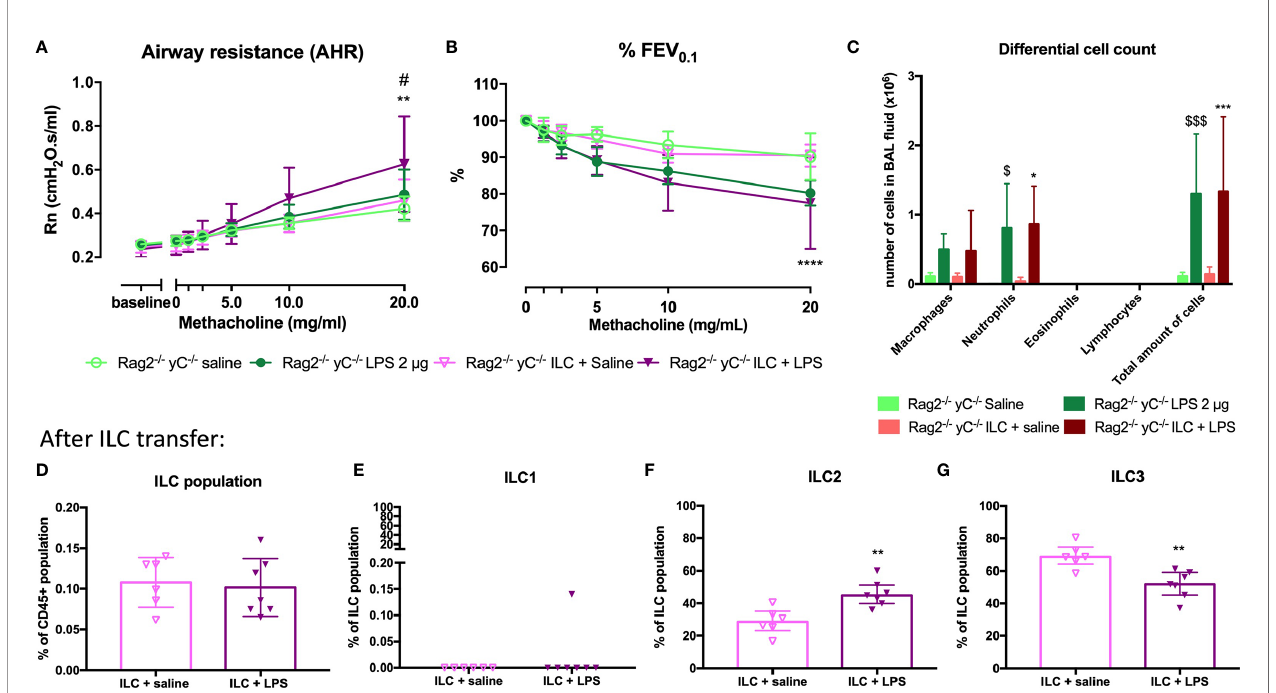
FIGURE 7 | Effect of adoptive transfer of ILC in Rag2 -/- g C -/- mice. ILC cells were isolated by sorting from lung tissue of SCID mice and intravenously injected (10 4 cells) in Rag2 -/- g C -/- mice. Twenty-four hours after the adoptive transfer, Rag2 -/- g C -/- mice were endonasally exposed to LPS (2 µg in 50 µl saline) on four consecutive days. Twenty-four hours after the last LPS challenge, lung function parameters were measured using the FlexiVent, and BAL fl uid was obtained for differential cell count and lung tissue for ILC identi fi cation. Airway resistance [Rn, (A) ] and FEV 0.1 [%, (B) ] before and after methacholine provocation (0 – 20 mg/ml) were measured in saline-treated Rag2 -/- g C -/- mice (n = 5), LPS-treated Rag2 -/- g C -/- mice (n = 6), saline-treated Rag2 -/- g C -/- mice after ILC transfer (n = 6), and LPS-treated Rag2 -/- g C -/- mice after ILC transfer (n = 6). Data are represented as mean with standard deviation. Two-way ANOVA was used to determine signi fi cant differences. Differential cell count in BAL fl uid of the same mice is shown in (C) . Total ILC population (D) , ILC1 (E) , ILC2 (F) , ILC3 (G) were identi fi ed in lung tissue via fl ow cytometry in saline-treated Rag2 -/- g C -/- mice with ILC transfer (n = 6) and LPS-treated Rag2 -/- g C -/- mice with ILC transfer (n = 6). These data are represented as individual values with median and interquartile range. Results from three independent experiments were combined. The unpaired t-test (D, F, G) or Mann – Whitney test (E) were used to calculate the p-value. *p < 0.05; **p < 0.01; ****p < 0.0001 (ILC + saline versus ILC + LPS). # p < 0.05 (LPS versus ILC + LPS); $ p < 0.05; $$$ p < 0.001 (saline versus